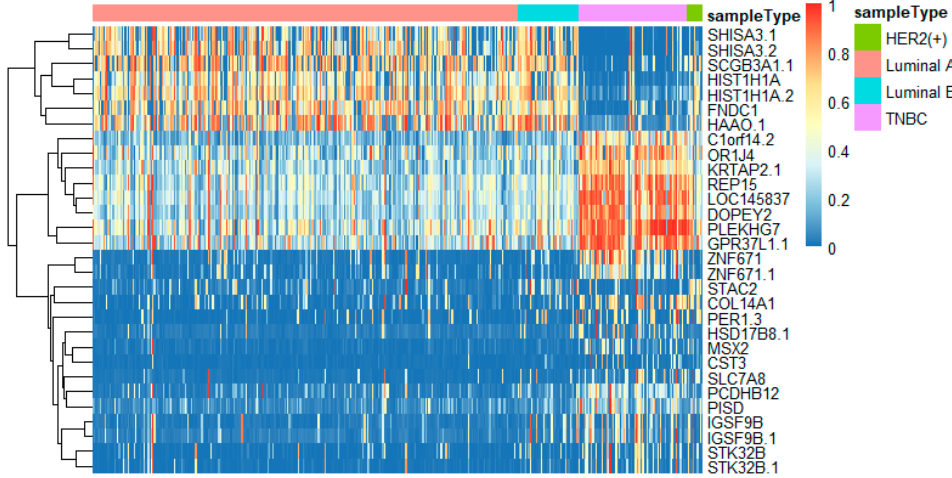
Figure 9. The heatmap of breast cancer subtypes on DNA methylation data.